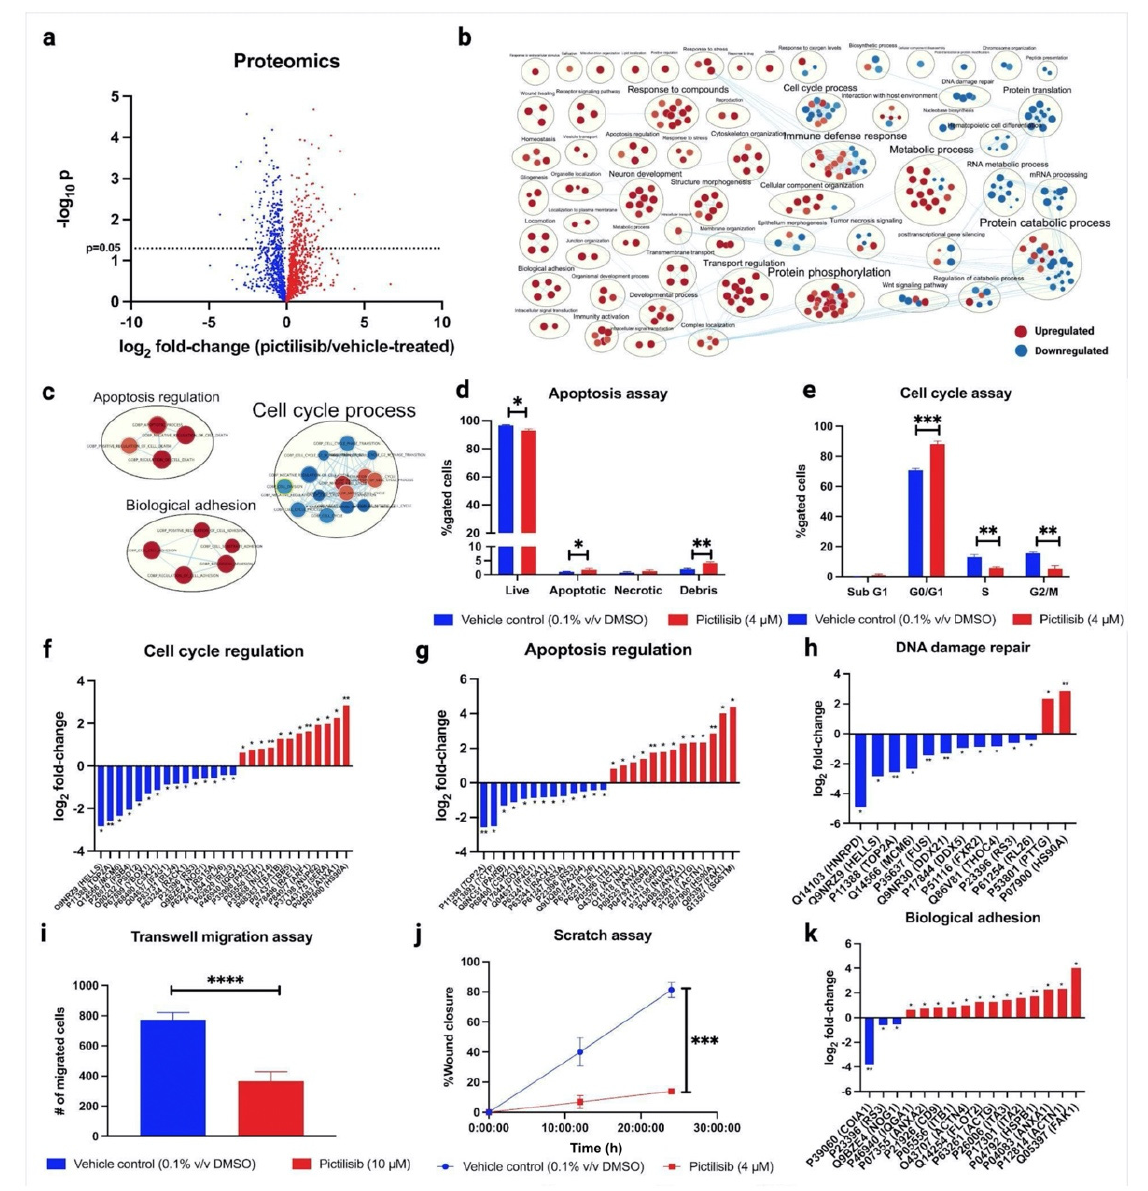
Figure 2. Pictilisib treatment significantly affected the pathways involving ECM interactions and migration, and cell death and proliferation, in A549. ( a ) Volcano plot of differentially expressed proteins in pictilisib-treated A549 cells; ( b ) Gene-set enrichment analysis of pre-ranked protein expression profiles of pictilisib- vs. vehicle control-treated cells; ( c ) Processes involved in apoptosis regulation and biological adhesion were upregulated, while processes involved in cell cycle regulation were downregulated; ( d , e ) In vitro assays of pictilisib-treated cells show significantly increased apoptosis and G0/G1 cell cycle arrest; ( f – h ) Quantification of proteins related to cell cycle regulation, apop- tosis regulation, and DNA damage repair show significant differences ( q -value < 0.05); ( i , j ) In vitro scratch and transwell migration assays show significantly reduced migration activity of pictilisib- treated cells; ( k ) Quantification of proteins related to biological adhesion shows significant differences ( q -value < 0.05). The data represent mean ± SD; n = 3. The statistical differences were detected utilizing multiple t -test with FDR correction, * q < 0.05; ** q < 0.01; *** q < 0.001; **** q <